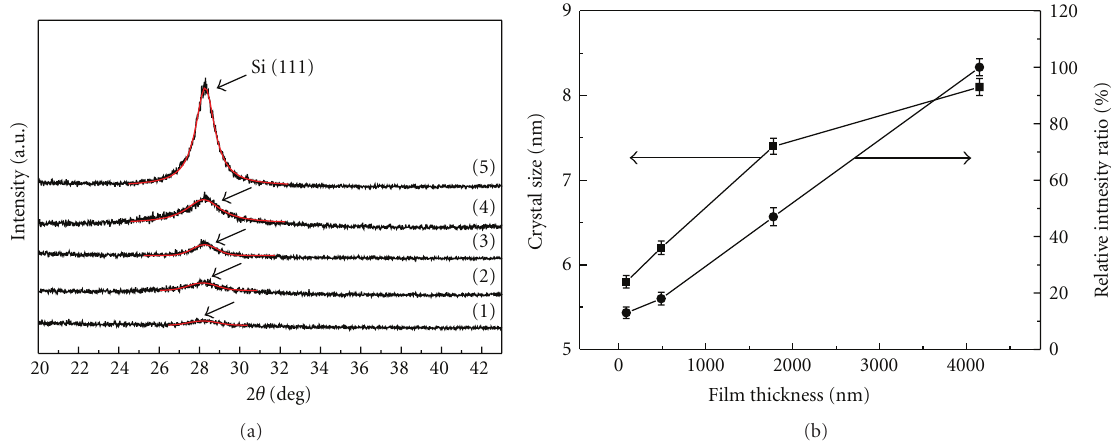
Figure 2: (a) XRD patterns of the Si thin films. The films were prepared at a substrate temperature of R.T. for 10 (1), 30 (2), 60 (3), 180 (4), and 360min (5), respectively. The arrow indicates the presence of (111) Si peaks in each spectrum. (b) Crystal size and relative peak intensity ratio (relative peak intensity ratio = (Intensity peak1,2,3,4,5 /Intensity peak5 ) × 100%) versus film